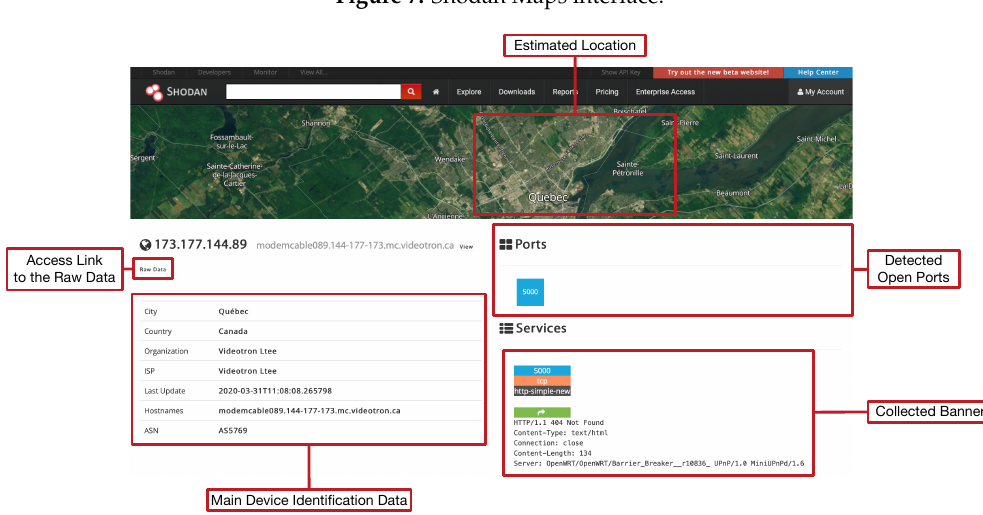
Figure 8. Shodan individual result data